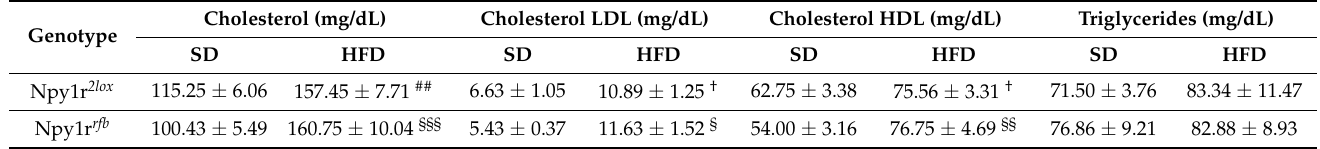
Table 1. Plasma level of total cholesterol, LDL, HDL and tryglicerides.